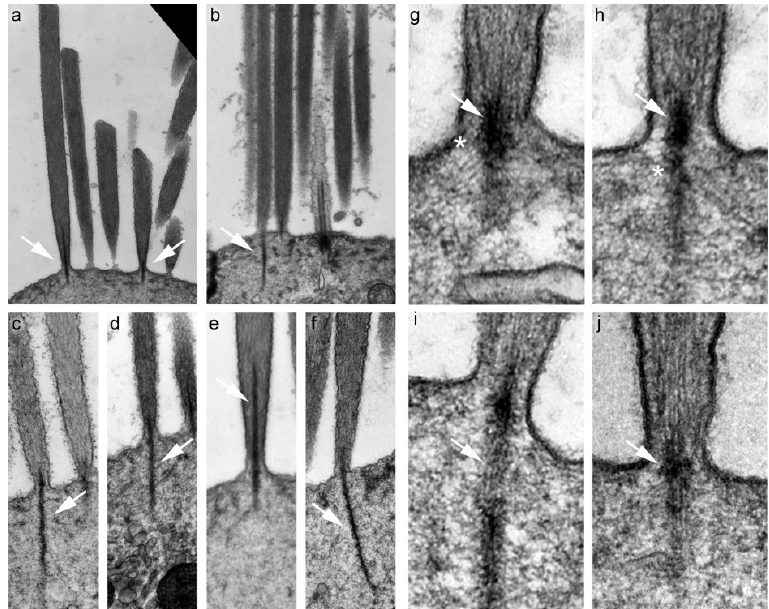
Figure 1. Rootlet structure as visualized with transmission electron microscopy (TEM). Each panel shows an image of a rootlet in a mouse utricle hair cell. Arrows indicate rootlets in each panel; arrows point to upper rootlets in ( a , e ), and to lower rootlets in ( b – d , f , i ). Arrows point to the rootlet at the insertion of the stereocilium into the soma in ( g , h , j ). The apparent length and location of a rootlet depends on the orientation of the thin section used for imaging, as well as the orientation of the rootlet within the stereocilia and cuticular plate. Asterisks in e and f indicate filaments that appear to connect the rootlet to the membrane and cuticular plate. Ages: ( a , b ) P12; ( c ) P5; ( d – f ) P12; ( g – j ) P5. Panel full widths: ( a , b ) 3000 nm; ( c – f ) 700 nm; ( g – j ) 350